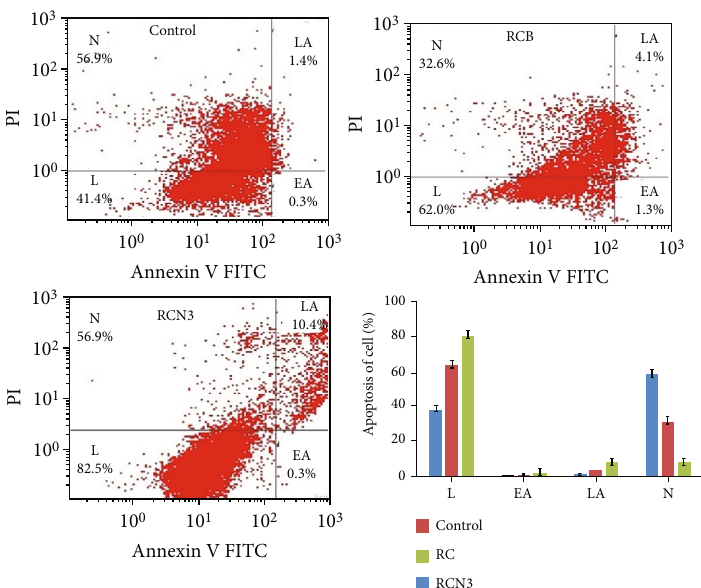
Figure 7: Apoptosis activity of control, free RC, and RCN3 against MCF-7 breast cell lines. Bar graph showing percent of live cells (L), early apoptosis (EA), late apoptosis (LA), and narcosis (N) induced by di ff erent treatments under investigation. Data are expressed as mean ± SD ( n = 3 ). ∗ indicates signi fi cant di ff erence between RCN3 ( p ≤ 0 : 05 ) and free RC and